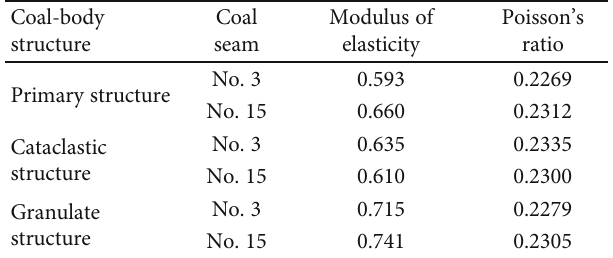
Table 3: Mechanical parameters of No. 3 and No. 15 coal seams in the Mabidong